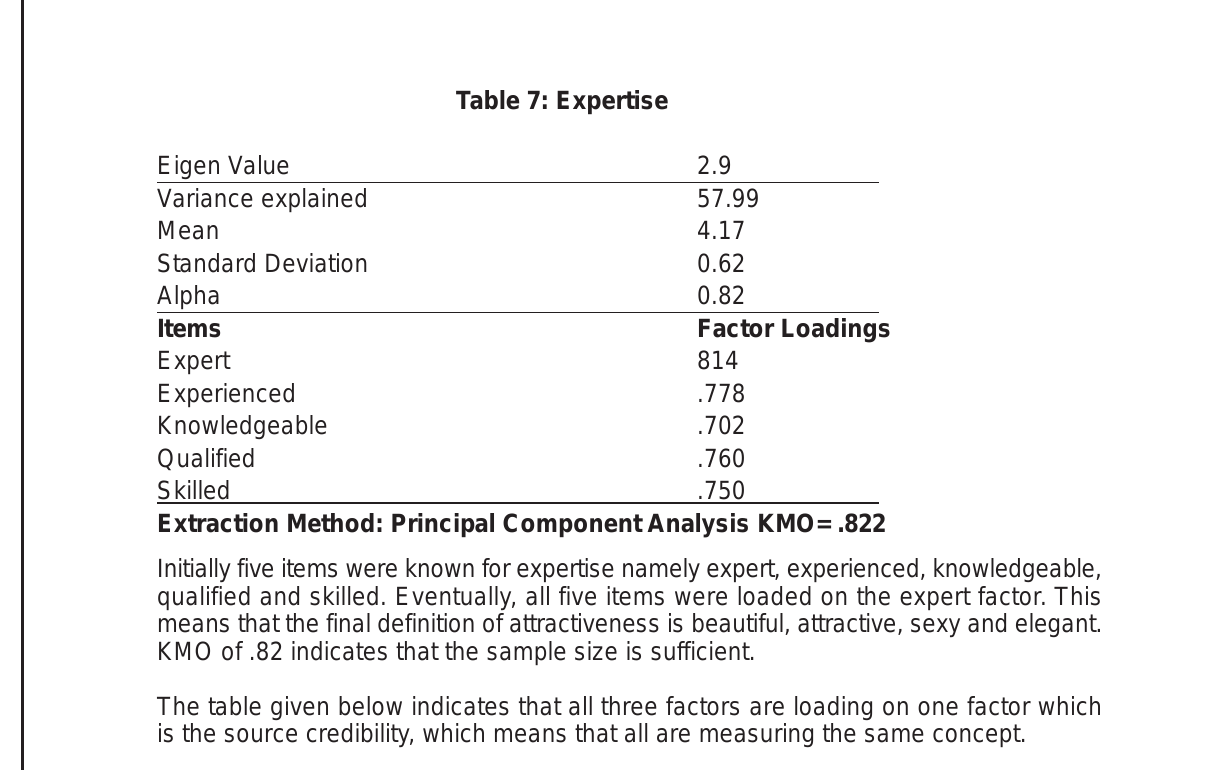
Table 8 FA: Source Credibility